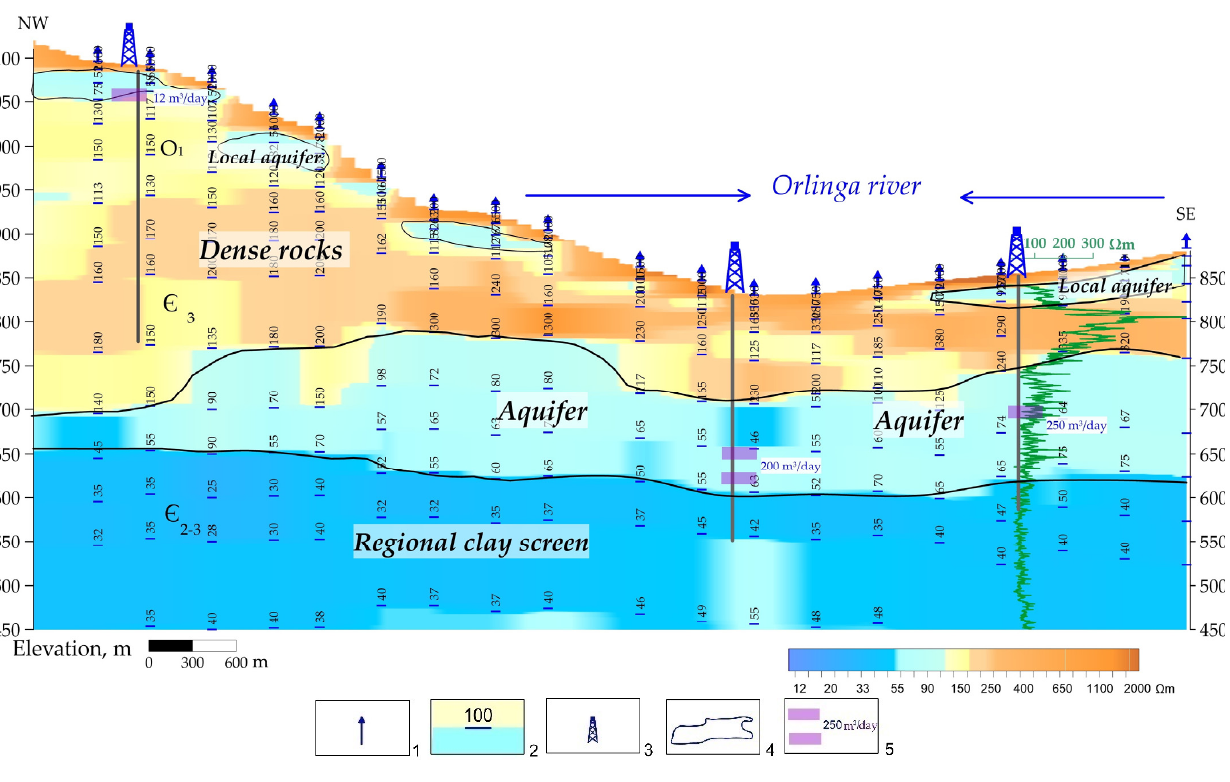
Figure 4. Resistivity pattern based on sTEM data from East Siberia. 1 = TEM stations; 2 = resistivity layers and their resistivity in Ohm · m; 3 = water test well; 4 = water-saturated reservoir inferred from sTEM data; 5 = water intervals and flow rate.